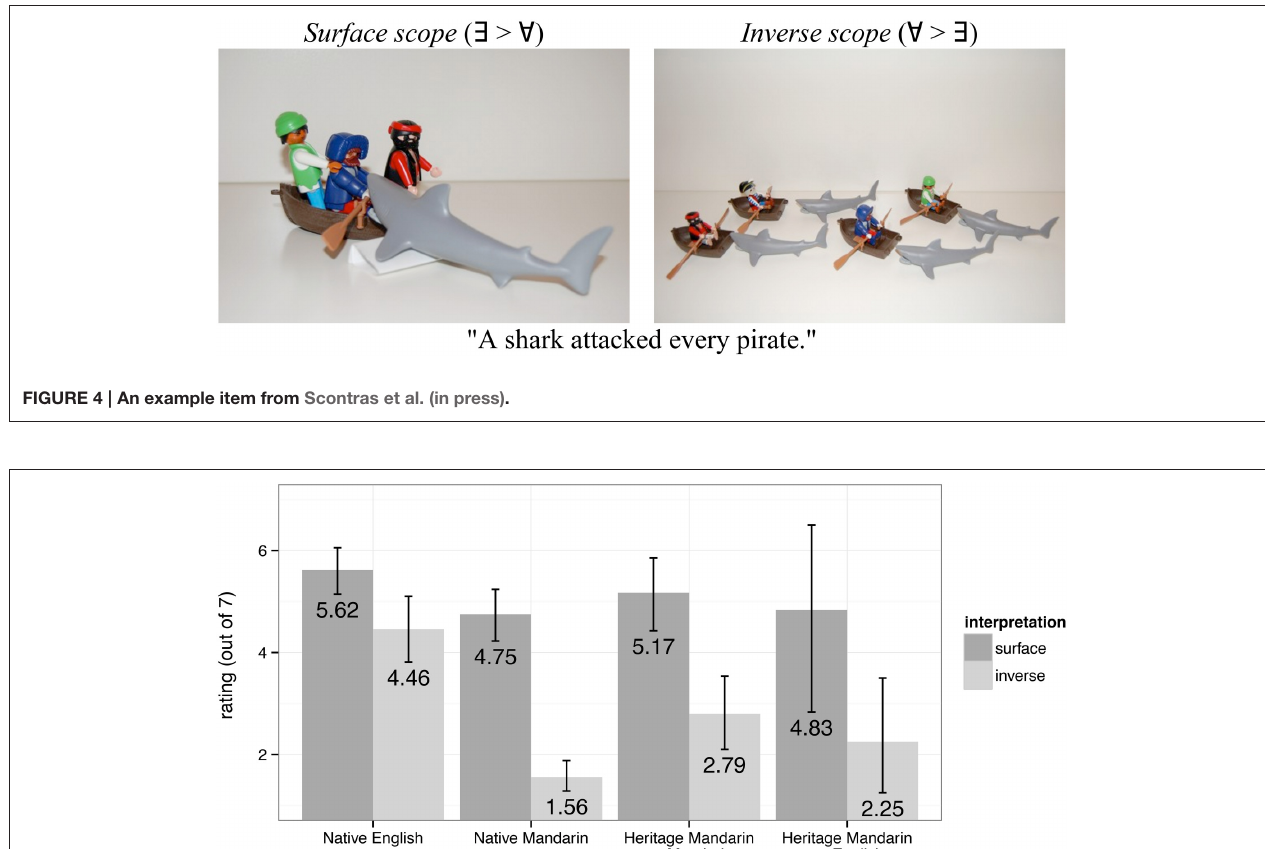
doubly-quantified sentences. This prohibition on inverse scope manifested as floor-level ratings, 1.56 out of a possible 7